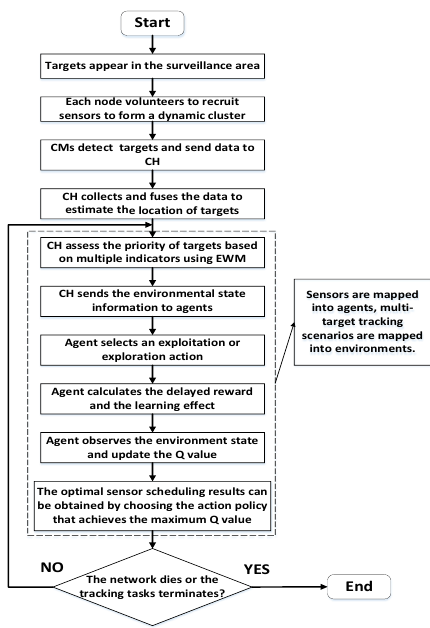
Figure 4. Flow chart of the proposed MTT-SS method.